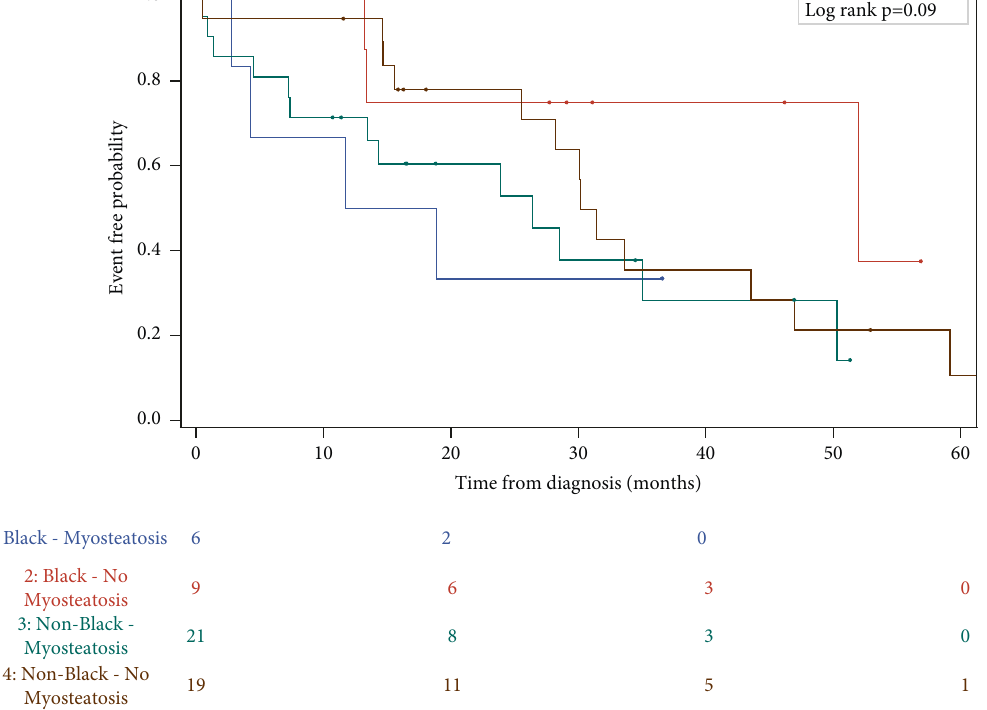
Figure 1: Overall survival by myosteatosis stratified by